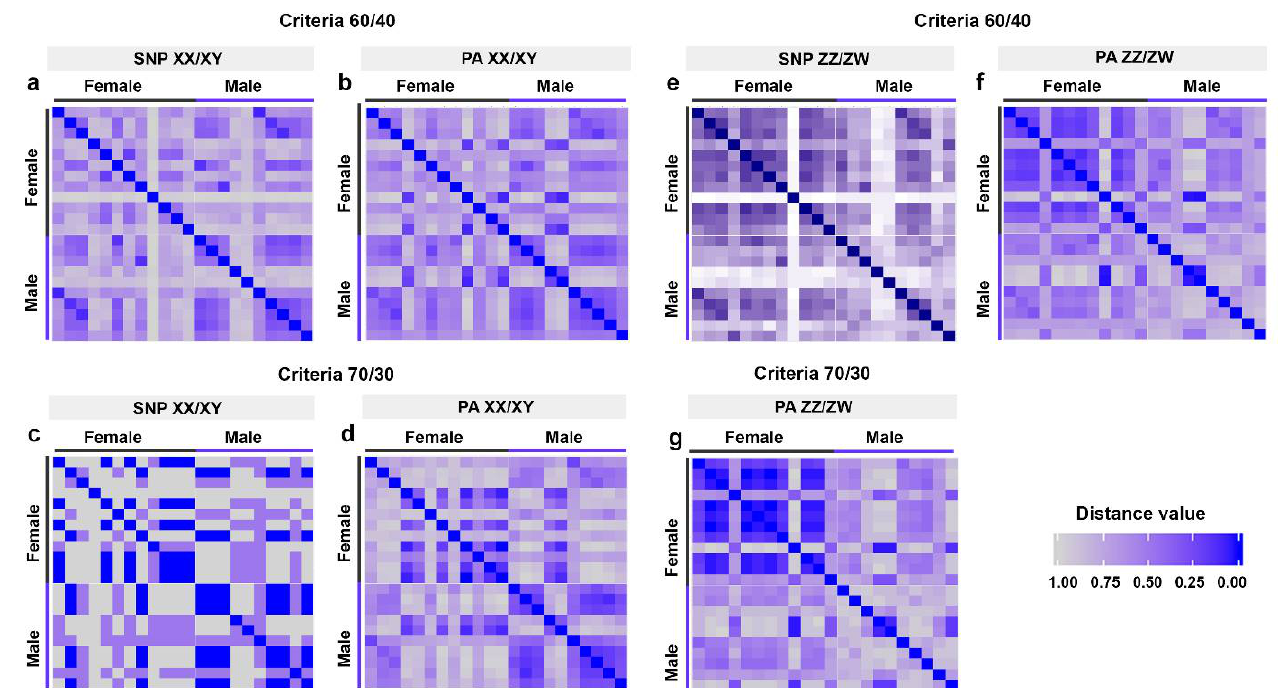
Figure 1. Hamming distance between male and female rice field frogs ( Hoplobatrachus rugulosus Wiegmann, 1834). Analysis in consideration of a XX/XY genetic sex determination system: ( a ) SNP loci filtered with the criterion of 60:40 (males:females), ( b ) PA loci filtered with the criterion of 60:40 (males:females), ( c ) SNP loci filtered with the criterion of 70:30 (males:females), and ( d ) PA loci filtered with the criterion of 70:30 (males:females). Analysis in consideration of a ZZ/ZW genetic sex determination system: ( e ) SNP loci filtered with the criterion of 60:40 (females:males), ( f ) PA loci filtered with the criterion of 60:40 (females:males), and ( g ) PA loci with the criterion of 70:30 (females:males). Table 1. DArT analysis of 10 male and 12 female rice field frogs ( Hoplobatrachus rugulosus , Wiegmann, 1834) (XX/XY sex determination type). 60:40 Male:Female 70:30 Male:Female 80:20 Male:Female 90:10 Male:Female 100:0 Male:Female After Before -